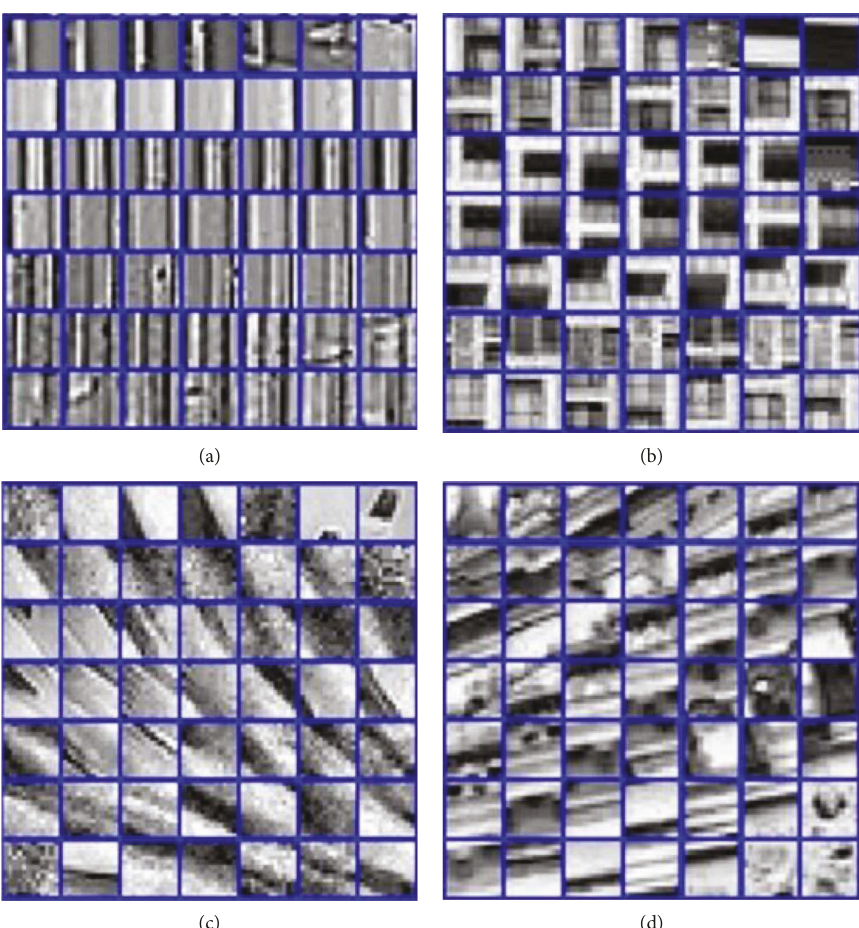
Figure 3: Partial elements of the four di ff erent HR feature patches: (a) 0 ° , (b) 90 ° , (c) 45 ° , and (d) 135 °